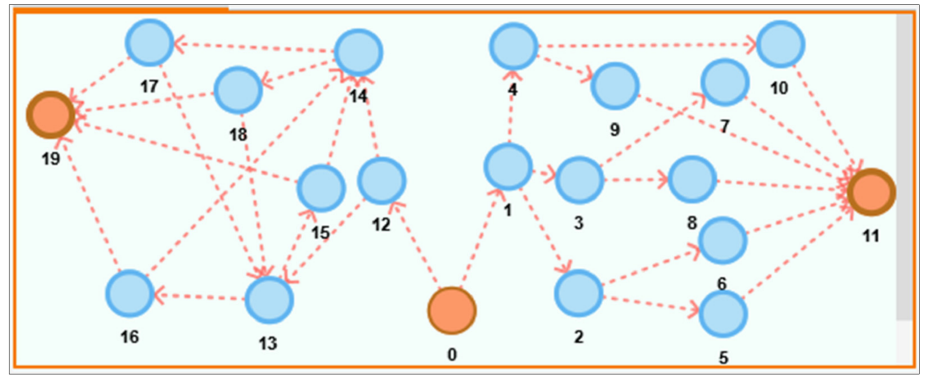
Figure 6. The obtained graph